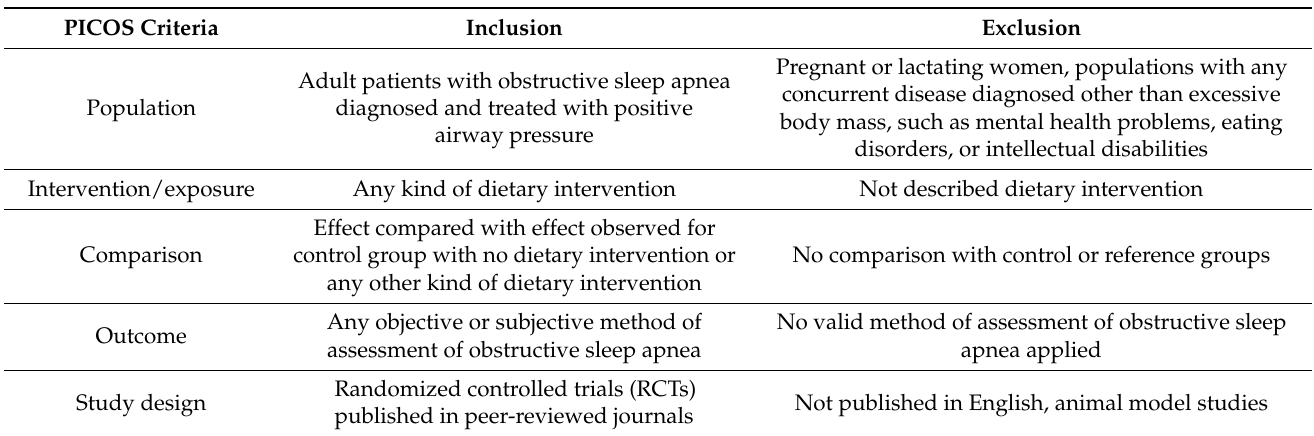
Table 2. Population, intervention/exposure, comparator, outcome, and study design (PICOS) criteria applied within this